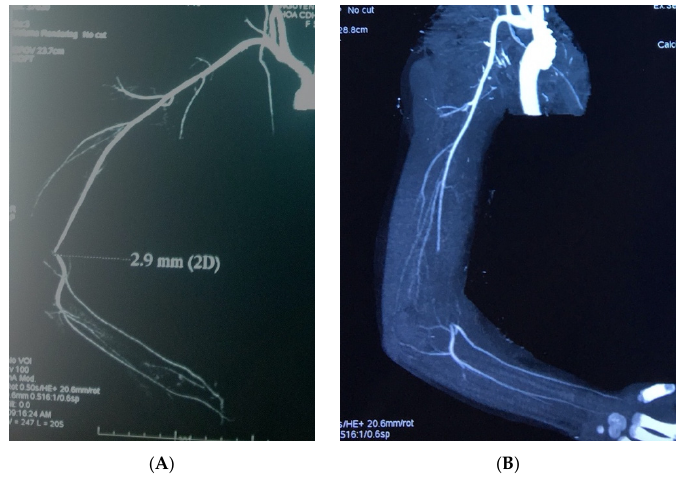
Figure 3. Brachial artery injuries in multislice CT-A. ( A ) Lesions < 5 mm. ( B ) Lesions ≥ 5